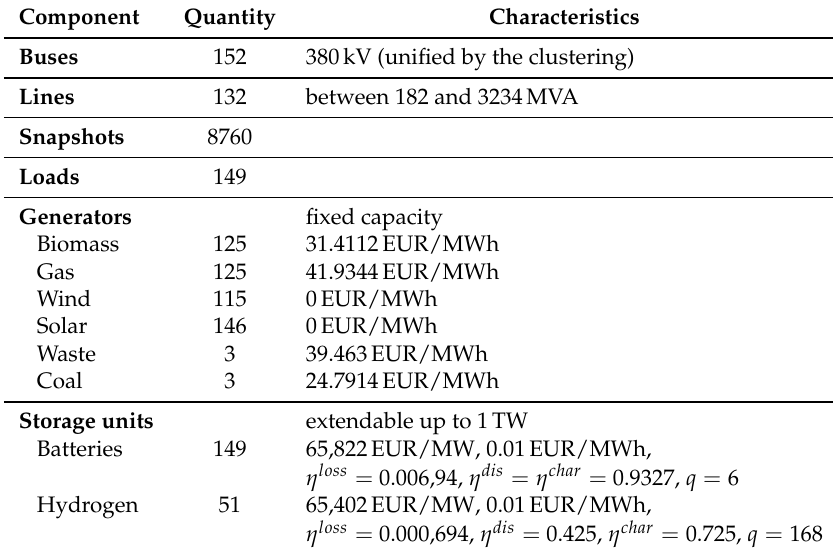
Table 2. Main characteristics of the power grid components. Generator costs (including fuel and CO 2 prices as well as variable and fixed costs) are derived by [12], storage units parameter by